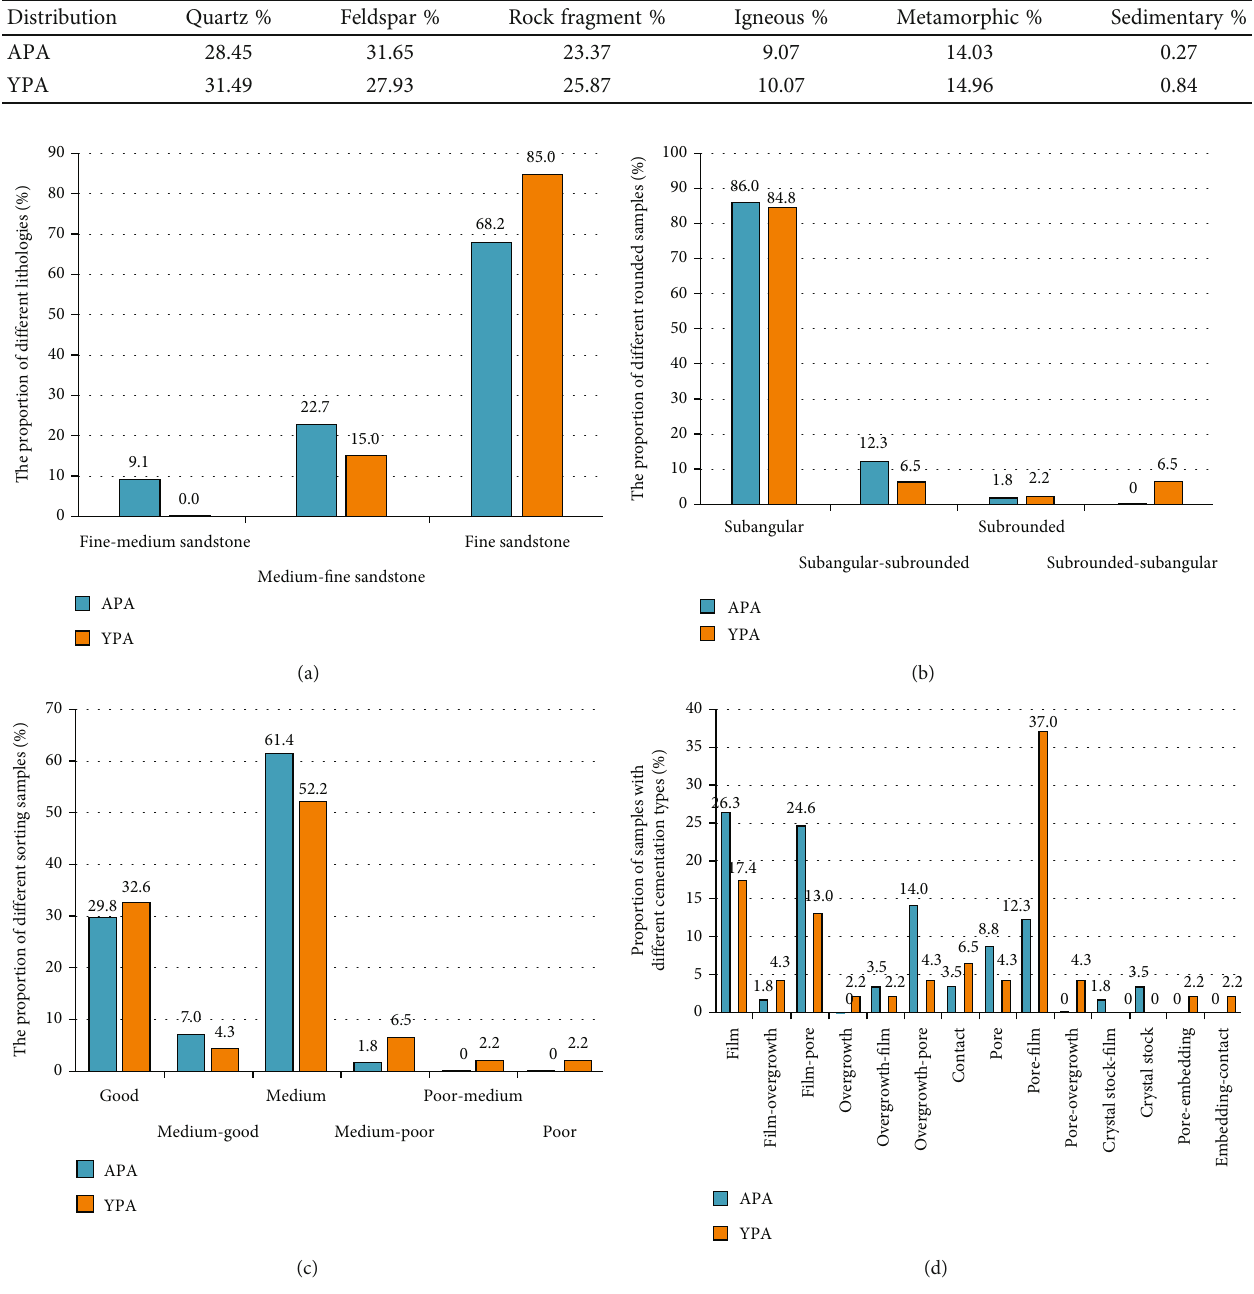
Figure 3: Comparison of rock di ff erences between the Chang 8 reservoirs in the APA and YPA. (a) Comparison of lithologic di ff erences 2 between the YPA and APA. (b) Comparison of rounding di ff erences between the YPA and APA reservoirs. (c) Comparison of reservoir sorting di ff erences between the YPA and APA. (d) Comparison of cementation types between the YPA and